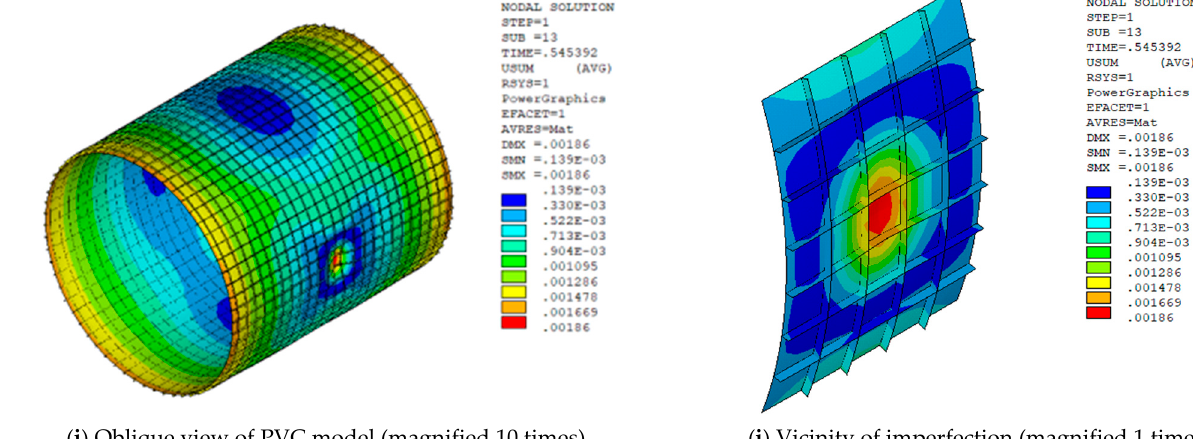
Figure 21. Comparison of buckling mode shapes between the prototype and distorted scale models when λ m = 0.060 m and δ 0 = 0.3 ⎯ t .